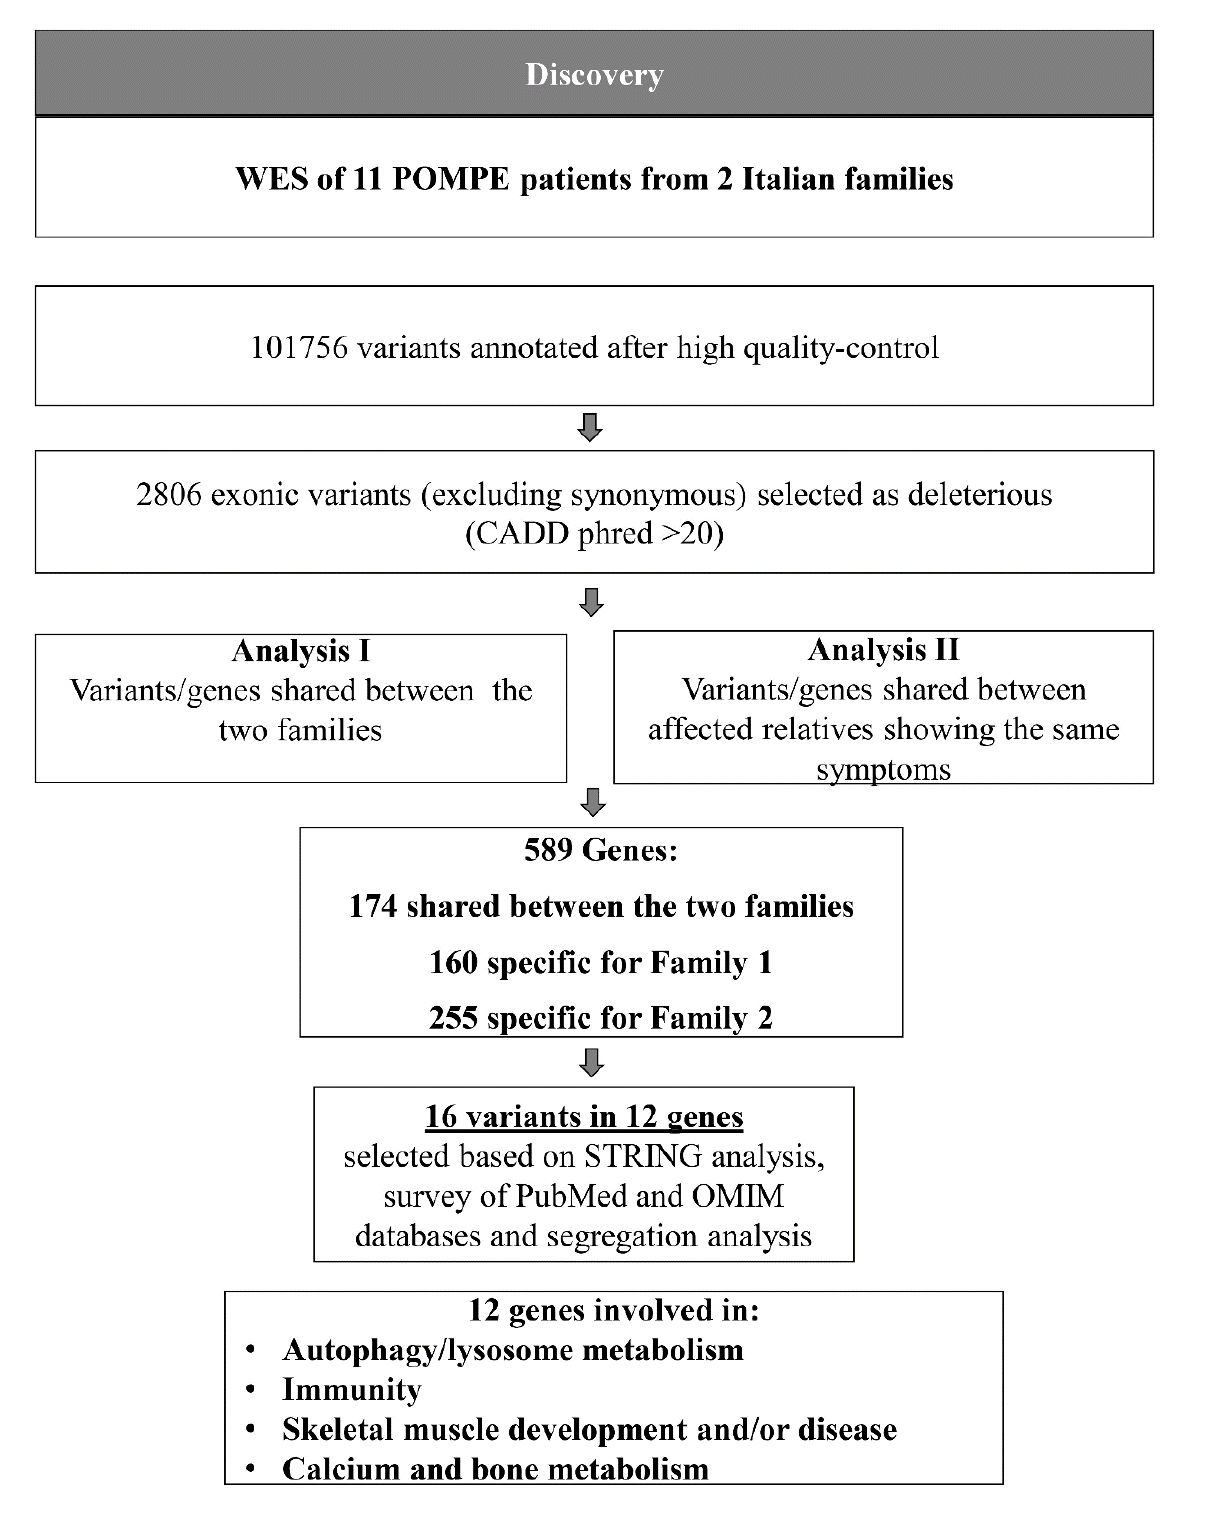
Figure 2. Pipeline of the analysis. The flowchart explains the analysis of WES data to identify the gene/variants shared between the two families (Analysis I) or between the affected relatives in each family (Analysis II). Functional annotation was performed with transcripts of the RefSeq and UCSC databases. MAF annotations were based on the 1000 Genomes project, Exome Variant Server, and the ExAC database. A CADD phred score > 20 was chosen to select deleterious variants.